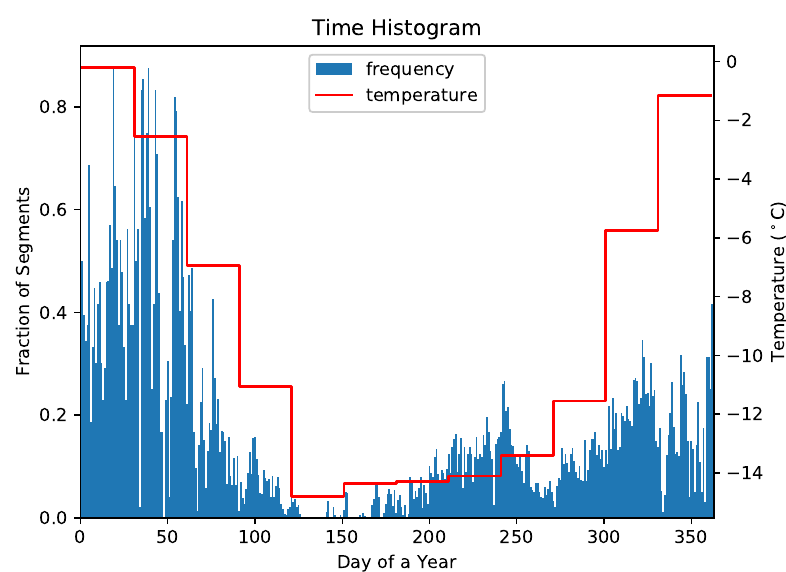
Figure 5. Fraction of Representative Segments and Average Temperature Over Different Time of